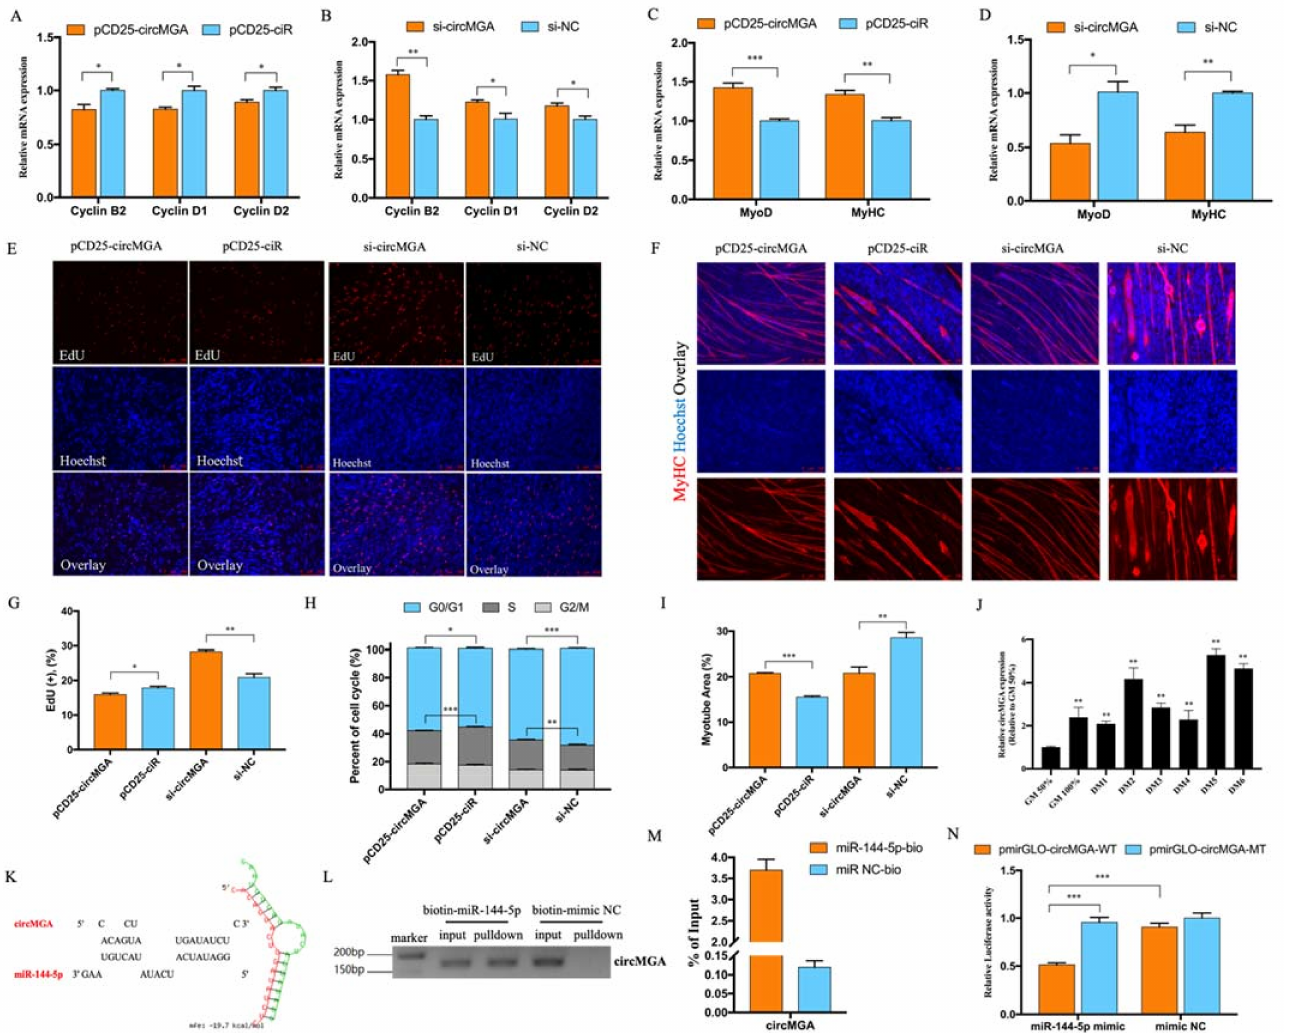
Figure 2. CircMGA depressed myoblast proliferation promoted myotube formation and sponged miR- 144-5p. ( A , B ) qRT-PCR results of Cyclin B2, Cyclin D1, and Cyclin D2 after circMGA overexpression and knockdown. ( C , D ) qRT-PCR results of MyoD and MyHC after circMGA overexpression and knockdown. ( E ) EdU staining and the positive EdU cell rate ( G ) for myoblast cell after circMGA overexpression and knockdown. ( F ) MyHC immunofluorescence staining of myotube and myotube area percentage ( I ) after transfection. ( H ) Cell cycle analysis after circMGA overexpression and knockdown. ( J ) The expression pattern of circMGA in different stages of myoblast differentiation. GM (growth media) stands for myoblasts in the proliferative phase. DM (differentiation media), DM1-DM6 means differentiation from day 1 to day 6. ( K ) RNAhybrid software analysis the potential binding site between circMGA and miR-144-5p. ( L , M ) Biotin-labeled miRNA pulldown revealed the interaction between circMGA and miR-144-5p. ( N ) Relative luciferase activity of pmirGLO-circMGA- WT/MT plasmid with miR-144-5p mimic or mimic NC. (* p < 0.05; ** p < 0.01, *** p <